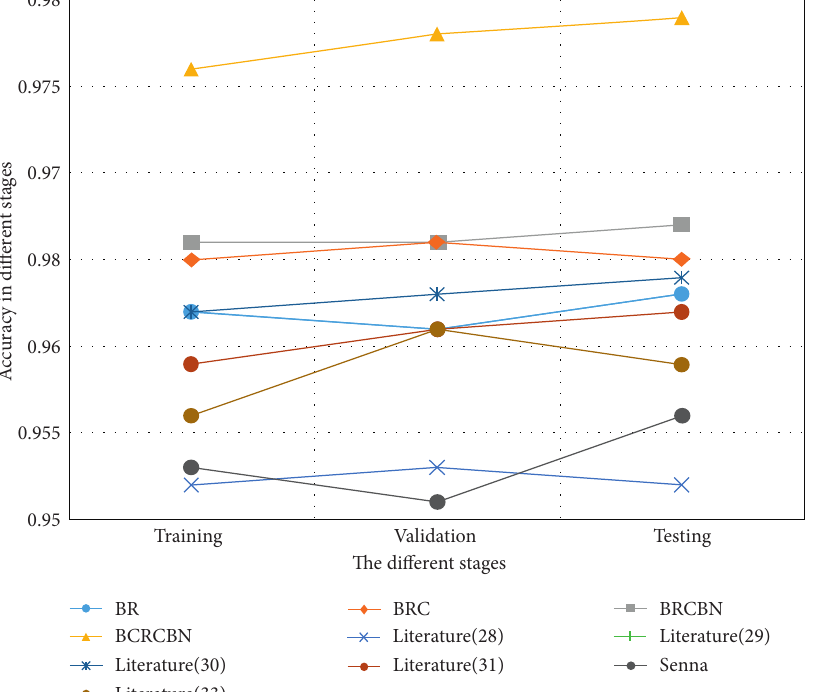
Figure 7: The accuracy of the model in Pigai corpus for part-of-speech